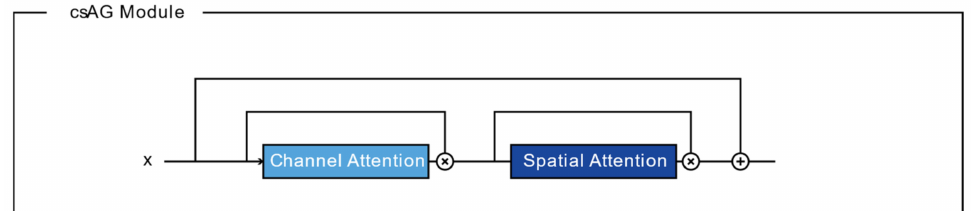
Figure 4. Structure of the csAG